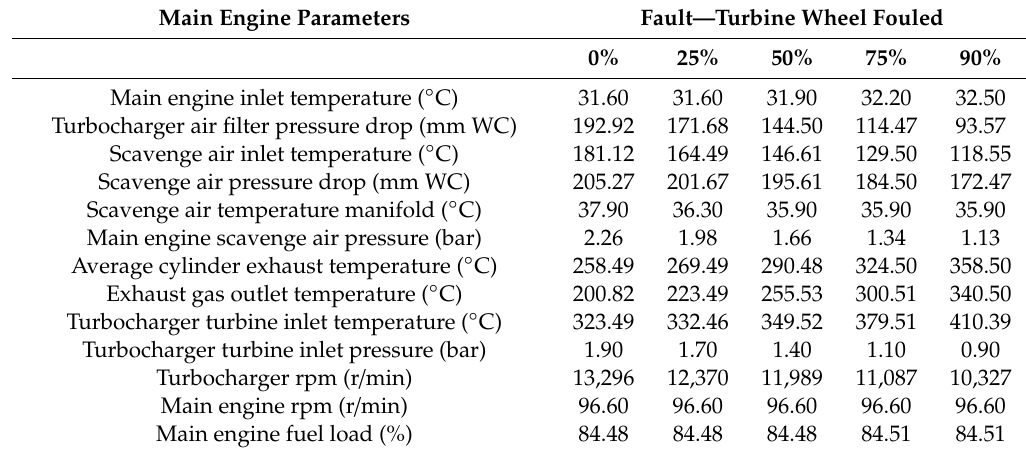
Table 5. Turbine wheel